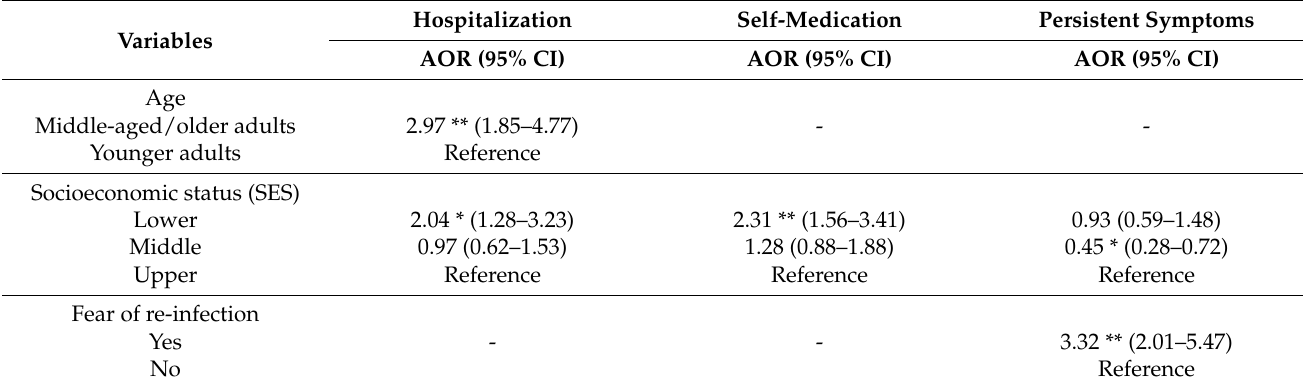
Table 3. Multivariate regression analyses for hospitalization, self-medication, and persistent symptoms showing significant adjusted odds